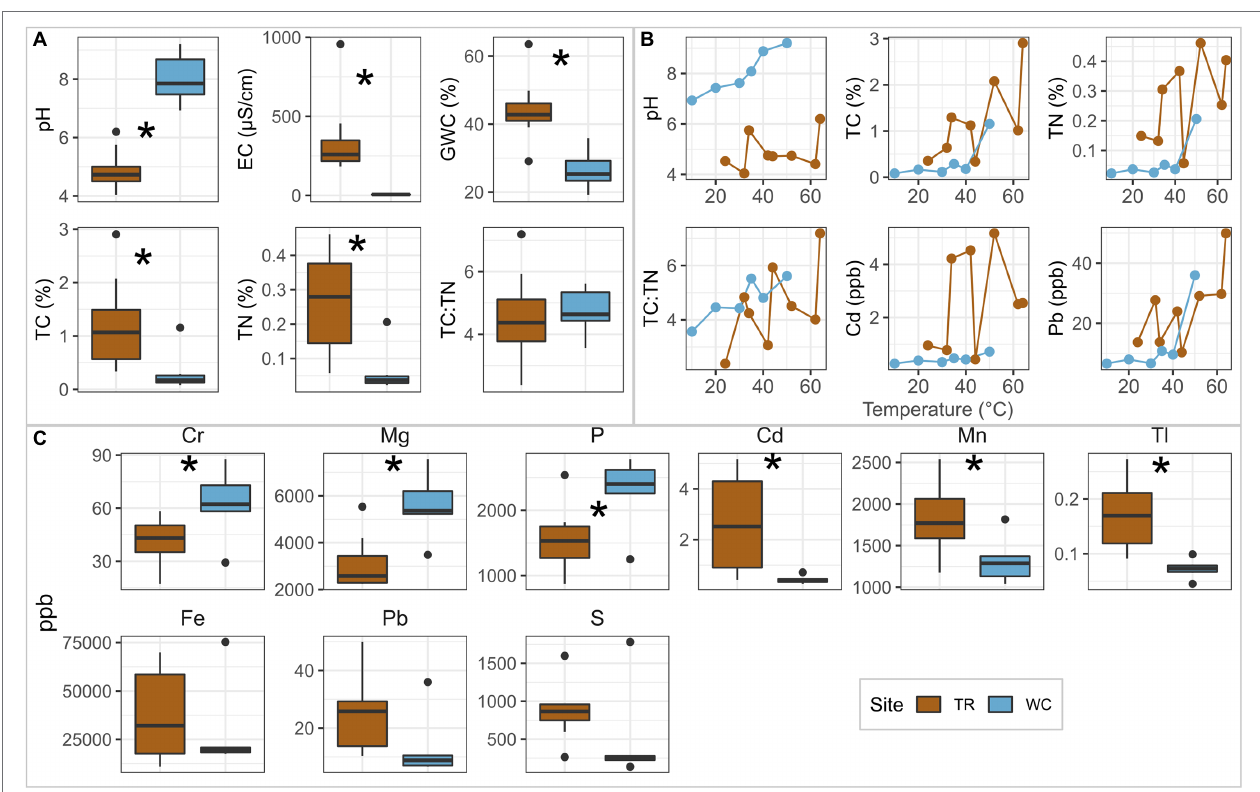
FIGURE 2 | Comparison of soil physicochemistry between Tramway Ridge (TR) and Western Crater (WC). (A,C) Boxplots for (A) each environmental parameter and (C) elements of interest that were significantly different between the two sites, showed significant trends with temperature, or are potential substrates for microbial metabolism. (B) Line plots showing the variation with temperature of environmental parameters and elements that were significantly correlated (Spearman’s correlation coefficient, p < 0.05) with temperature at one of the two sites; all significant correlations were found at WC. Elements were grouped by their patterns of difference between sites. * indicates significant difference between samples from the Western Crater transect and both Tramway Ridge transects (two- sided t -test, p < 0.05). Ppb: concentration in parts per billion. GWC: gravitational water content. TC: total carbon; TN: total